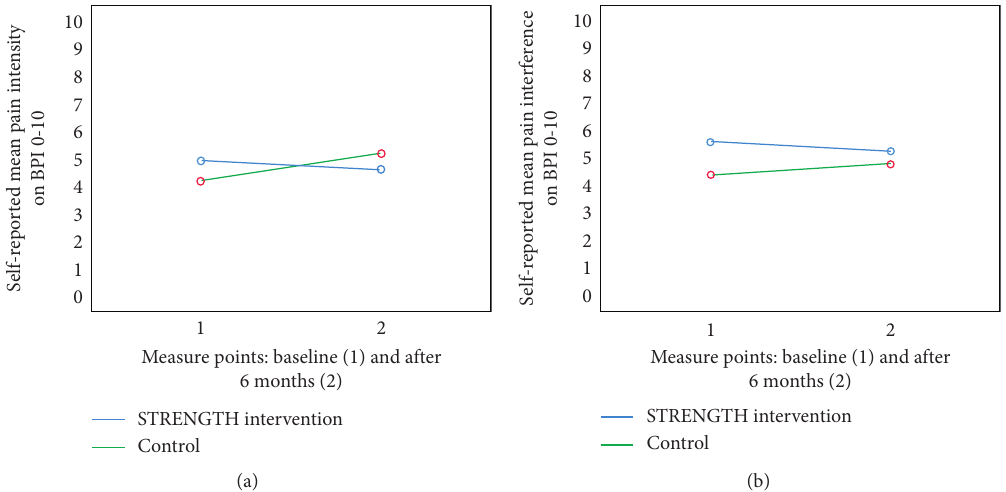
Figure 2: (a) Reported level of pain intensity at baseline and after intervention: STRENGTH (BPI 0–10) ( n � 18) versus control ( n � 12). (b) Reported level of pain interference at baseline and after intervention: STRENGTH (BPI 0–10) ( n � 18) versus control ( n � 12).